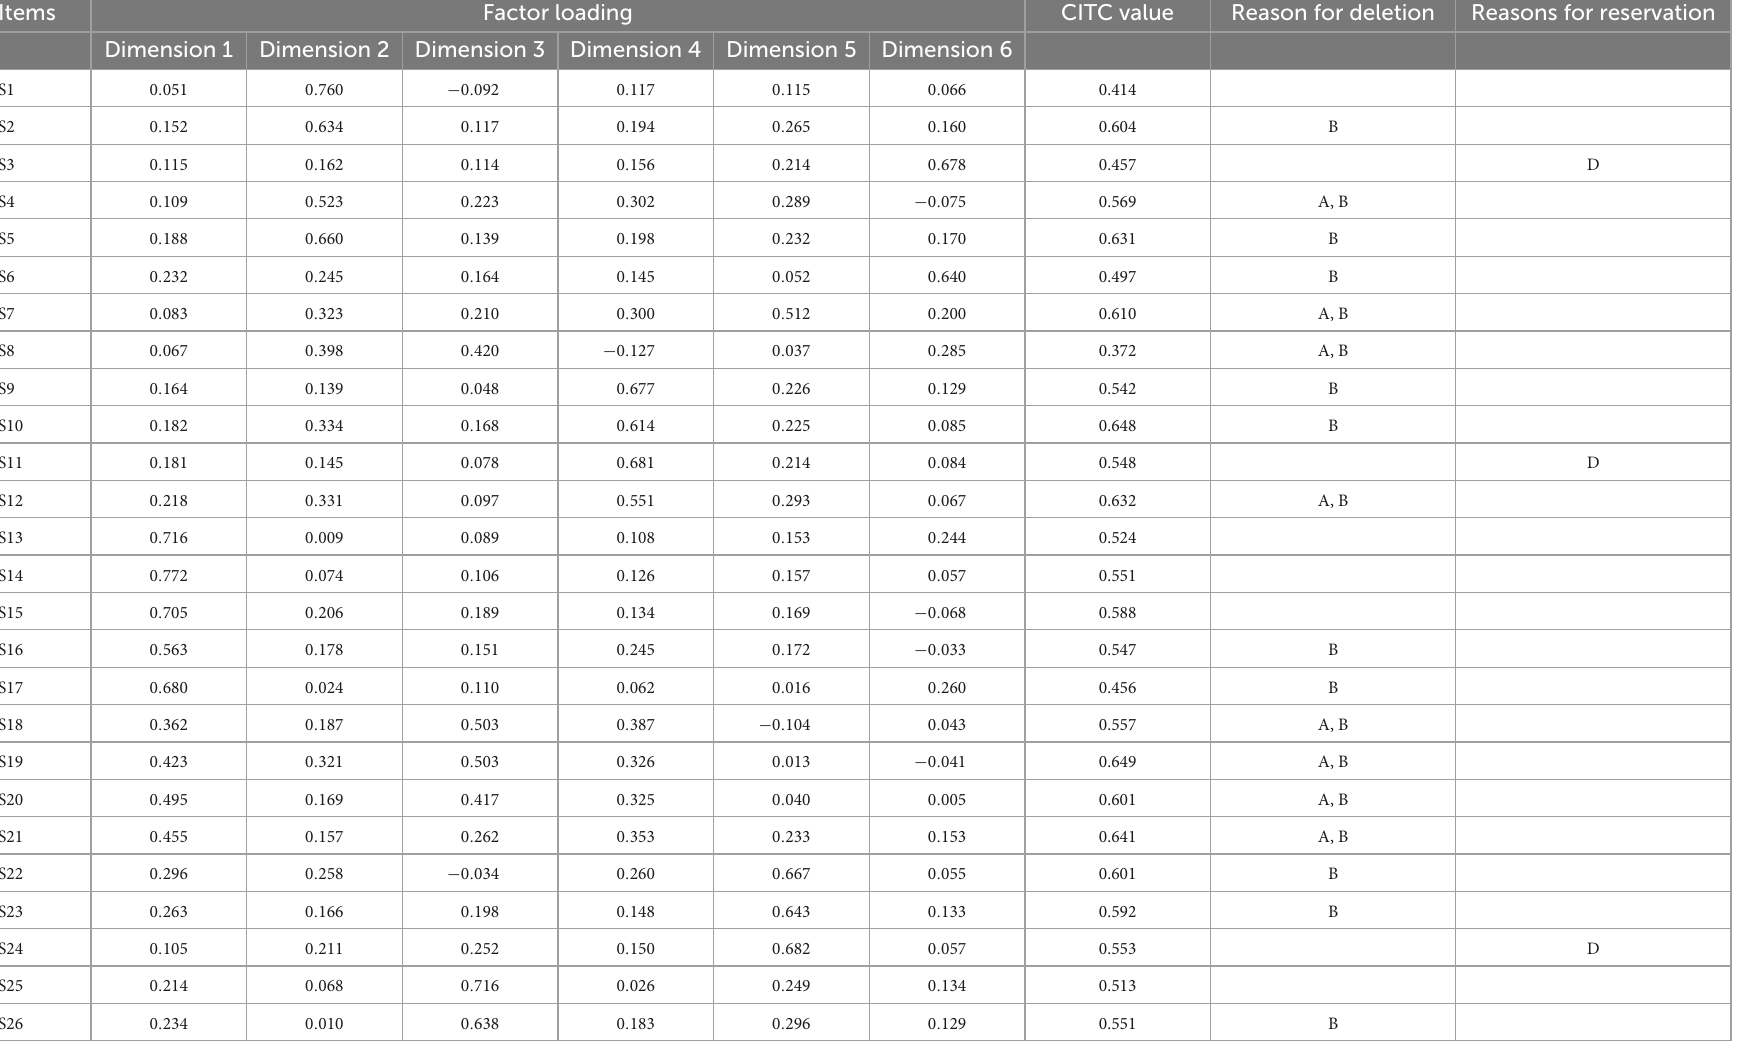
TABLE 4 Factor analysis of subsample II.